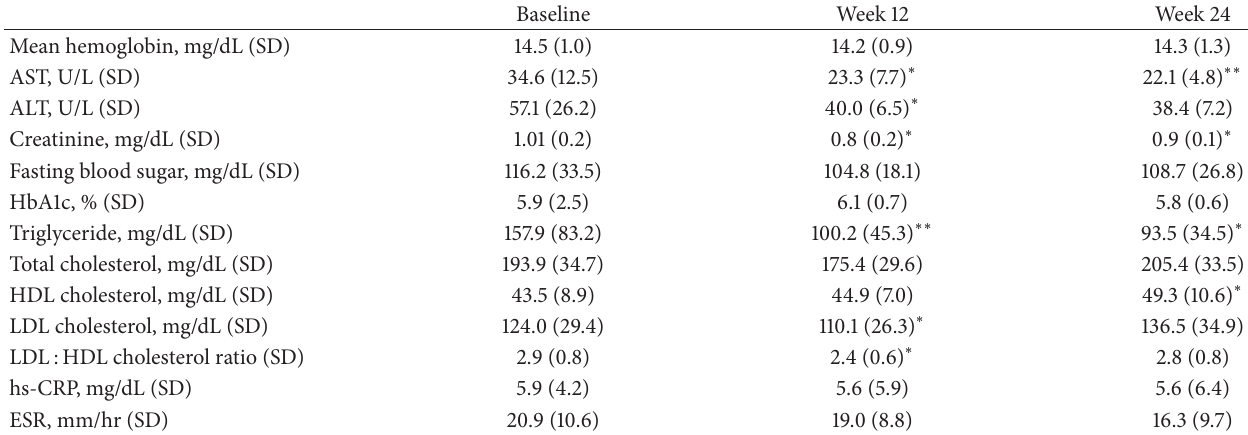
Table 4: Serum variables for the study population at baseline and weeks 12 and